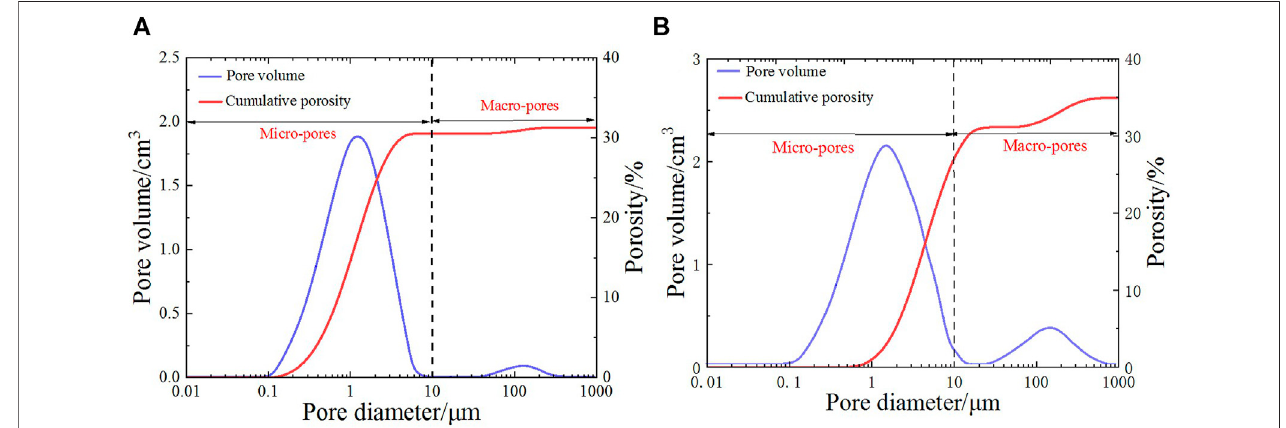
FIGURE 5 | Pore volume distributions of GRS: (A) original specimen, (B) F-T specimen.